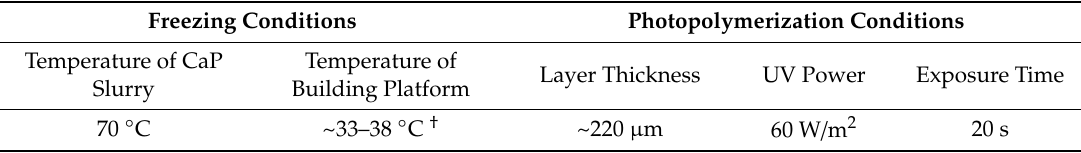
Table 2. Processing parameters used for the manufacturing of the hierarchically porous CaP sca ff